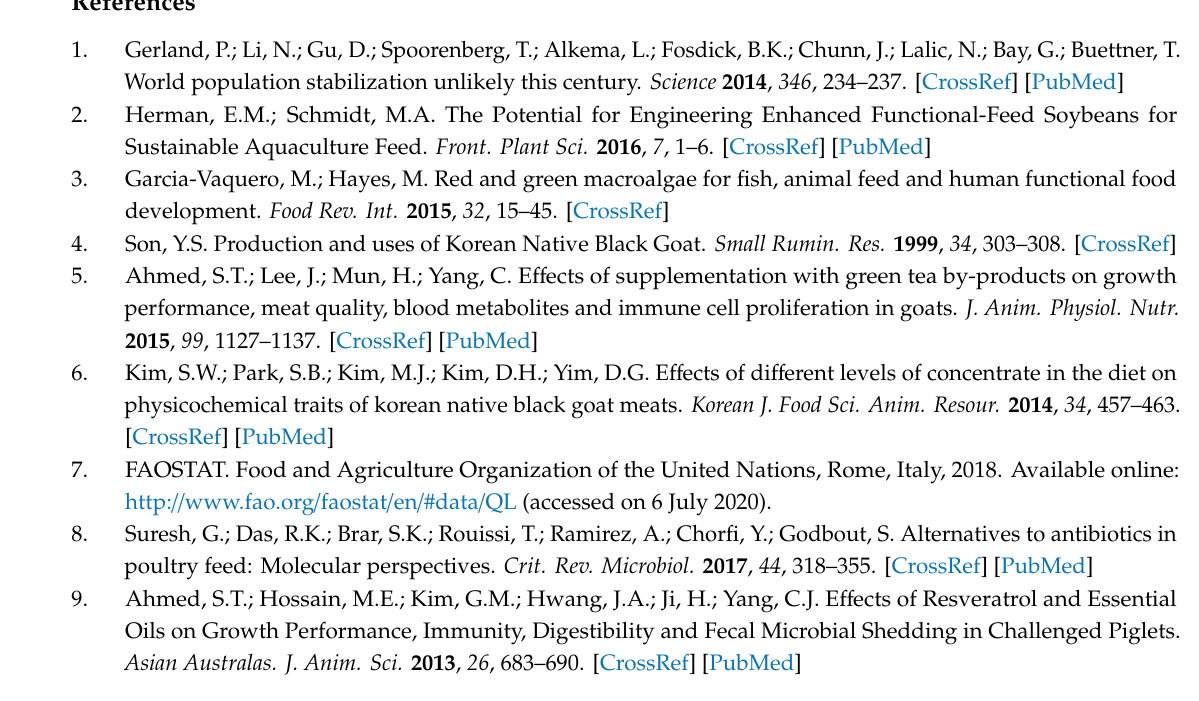
Table S1: Treatment compositions for screening of feed additives, Table S2: Proximate composition of milled plant powder mixed with rice bran before fermentation, Table S3: Proximate composition of milled plant powder mixed with rice bran after fermentation, Table S4: Microbiological count of the fermented feed additive treatments, Table S5: Cost of plant-derived feed ingredient per